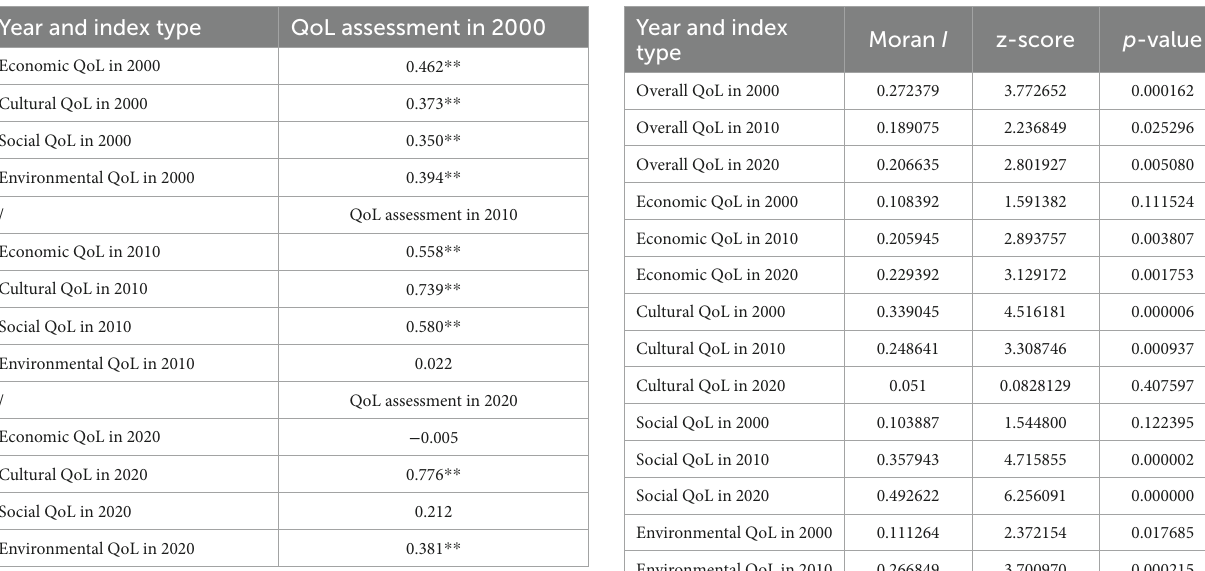
TABLE 3 Analysis of Pearson correlation coefficient between the overall quality of life evaluations and the secondary indexes.